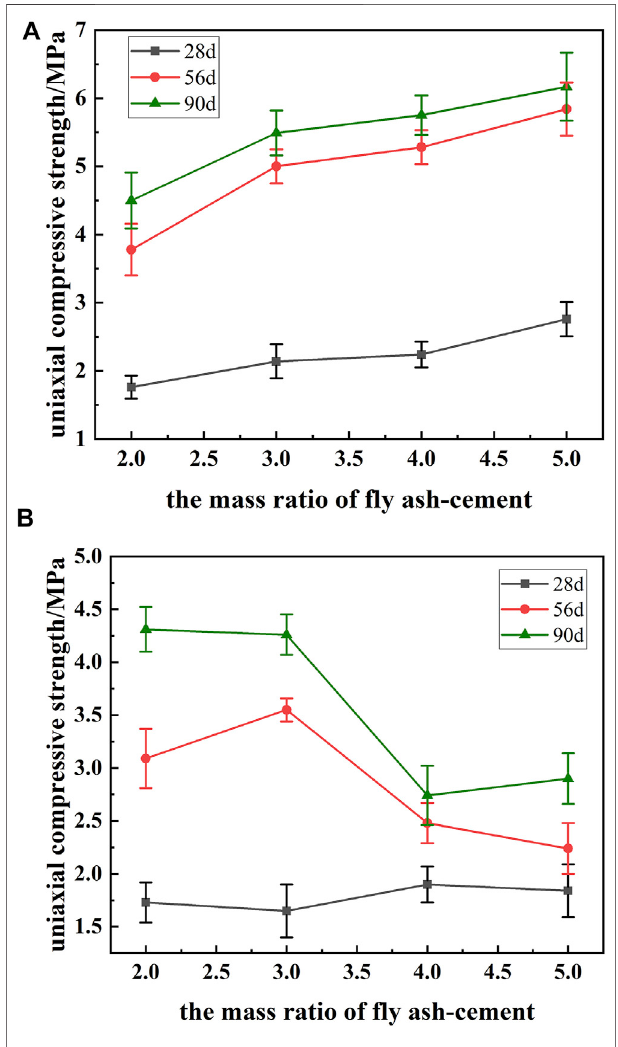
FIGURE 8 | Relationship between the strength of back fi ll and fl y ash content. (A) Group A. (B) Group B.